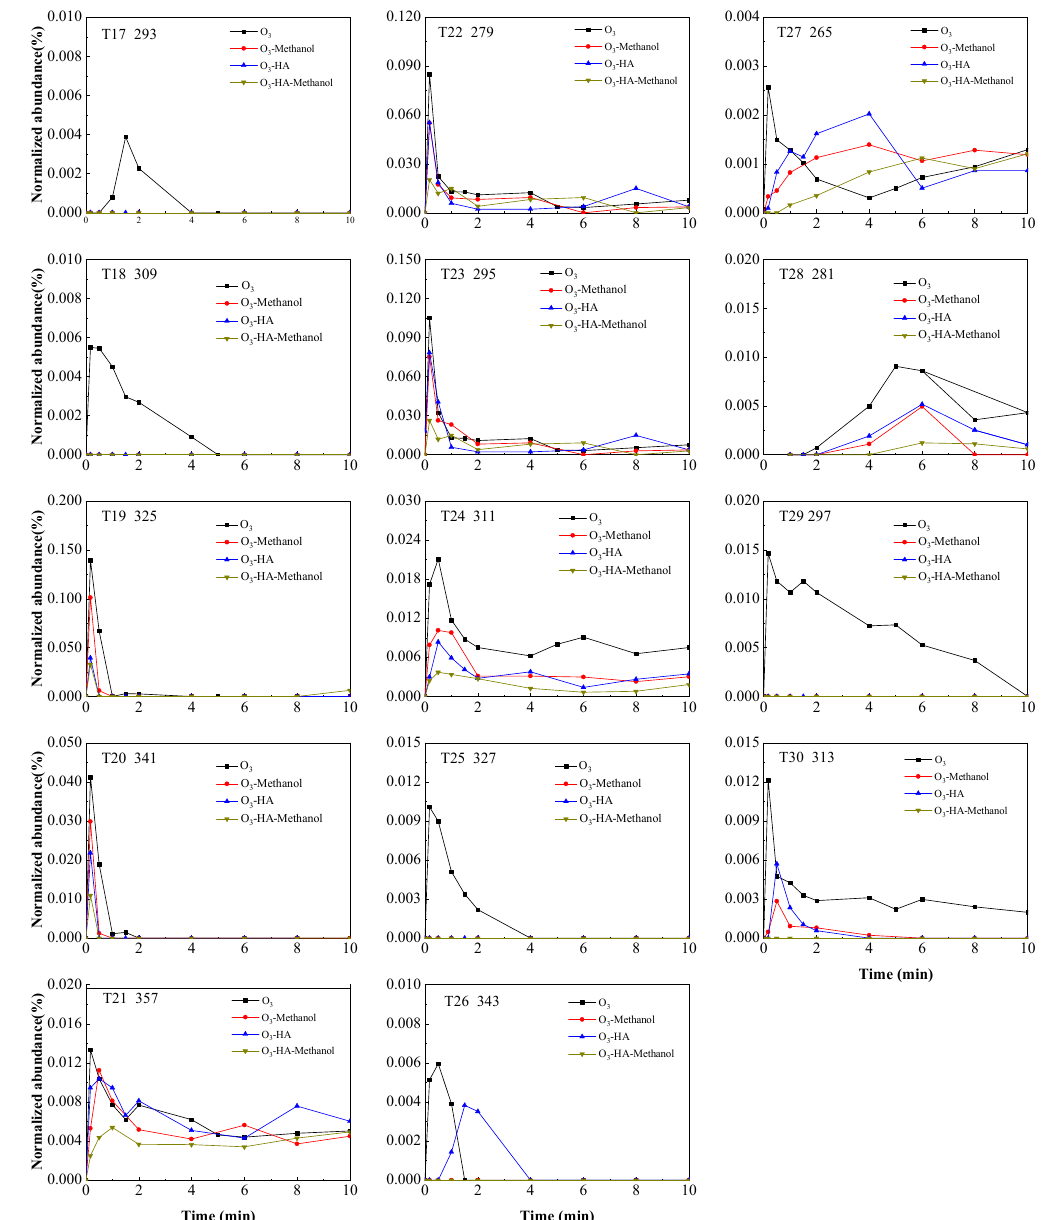
Figure 6. Formation of hydroxylated demethylation products during TMP ozonation (initial TMP concentration = 10 mg/L, initial pH = 6.0 ± 0.1, 20 °C).